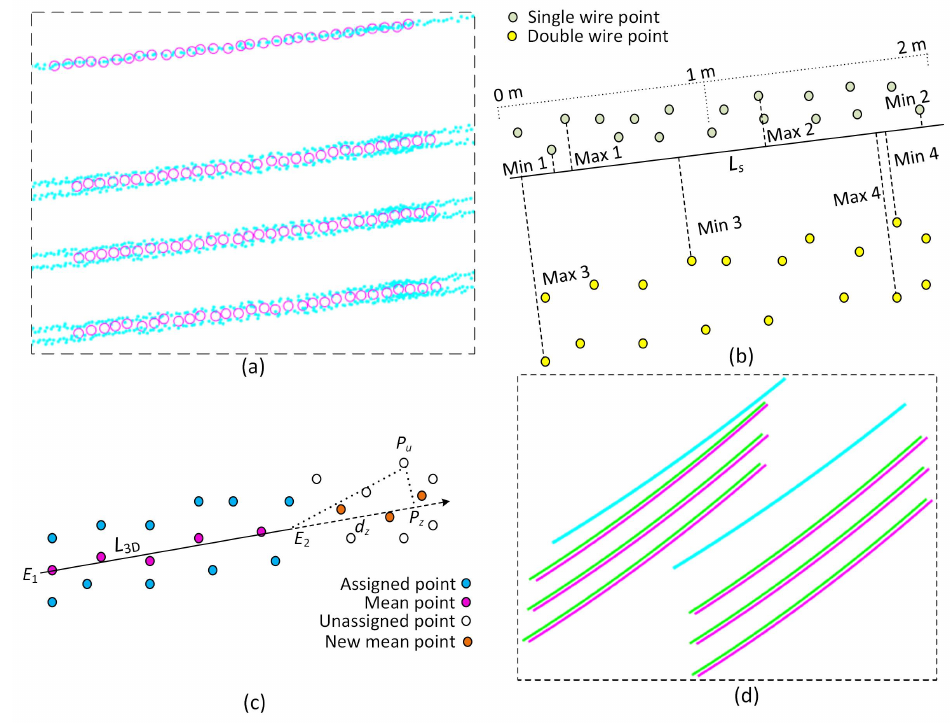
Figure 13. Wire extraction: ( a ) initial segments; ( b ) examining single and double wires; ( c ) extending an initial segment; and ( d ) 3D models for the sample scene in Figure